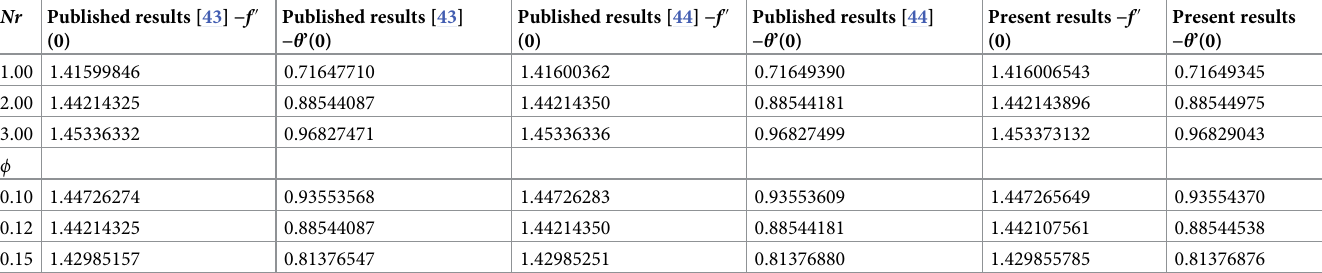
Table 2. Comparison between present and Rashidi et al. [43] & Dogonchi and Ganji [44] results for − f @ (0) and − θ